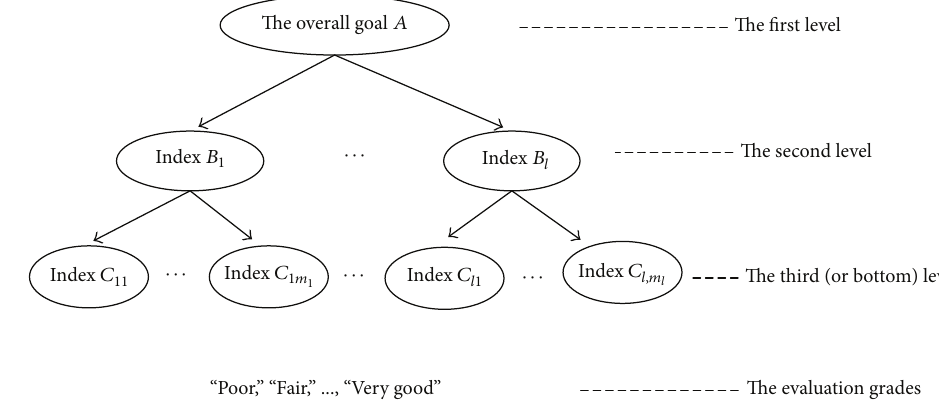
Figure 3: A simple hierarchical index